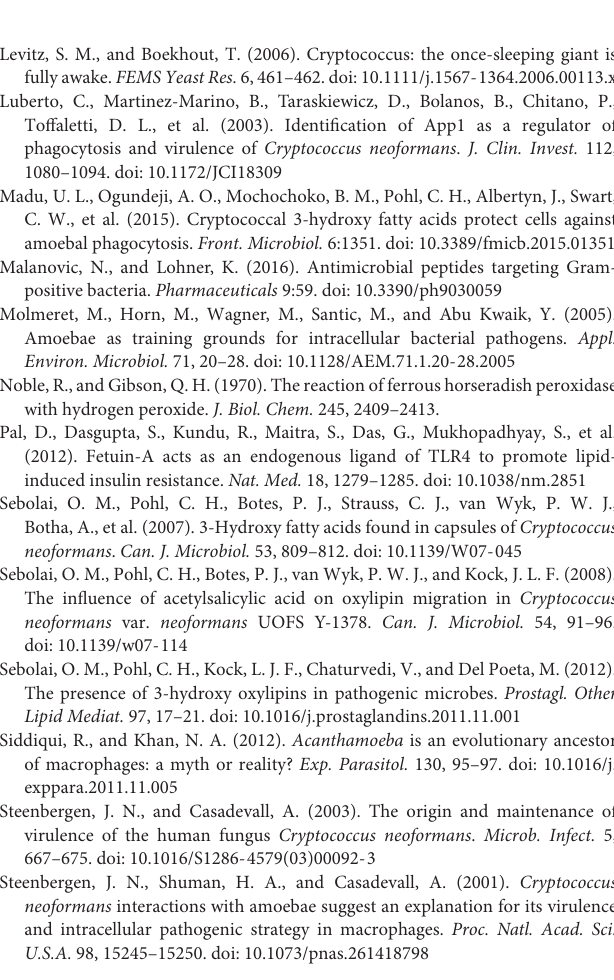
FIGURE S1 | (A) Shows a positive agglutination test for the isolated GXM while (B) also shows a positive ELISA result for the isolated GXM. Both these tests confirm the successful isolation of GXM in our study after it was harvested using irradiation. FIGURE S2 | The survival assay results showing the number of colony forming units (CFUs) that were enumerated after the strain C. neoformans UOFS Y-1378 was exposed to different treatment conditions. The results suggest that 3-hydroxy C9:0, similar to GXM, protect cells against oxidative damage. FIGURE S3 | The fate of hydrogen peroxide in media containing hydrogen peroxide-treated cells as well as hydrogen peroxide-treated cells in the presence of GXM or 3-hydroxy C9:0. (A) Shows results for the strain C. neoformans LMPE 101 while (B) shows results for the strain C. neoformans UOFS